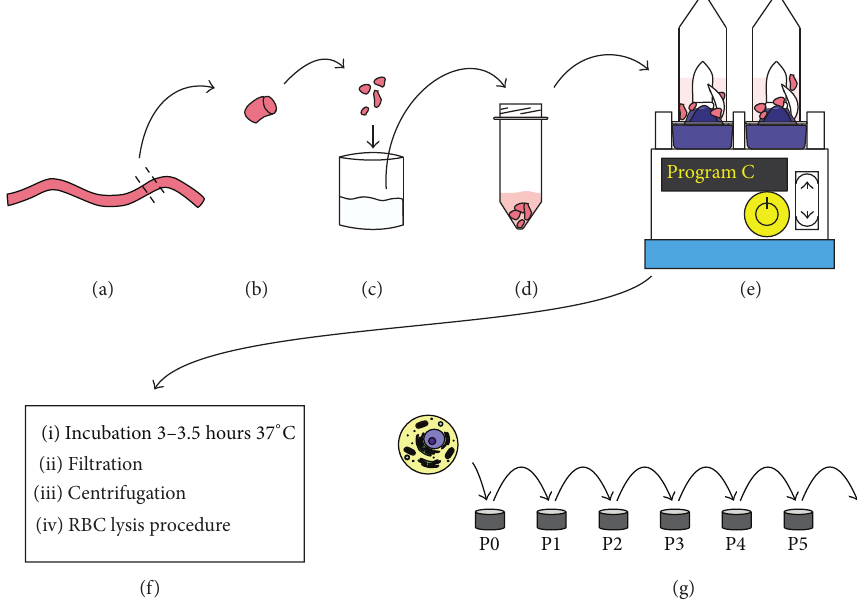
Figure 1: A schematic of the optimized isolation method. The major steps: (a) umbilical cord selected. (b) 1cm section prior to cutting into 4 equal pieces. (c) Cord pieces rinsed in DPBS. (d) The cord pieces inside a C-tube immersed in enzyme solution. (e) Dissociation with C- tubes and Miltenyi Dissociator. (f) Steps following dissociation prior to plating the isolated cells. (g) The isolated cell initial plating at P0 and subsequent expansion over multiple